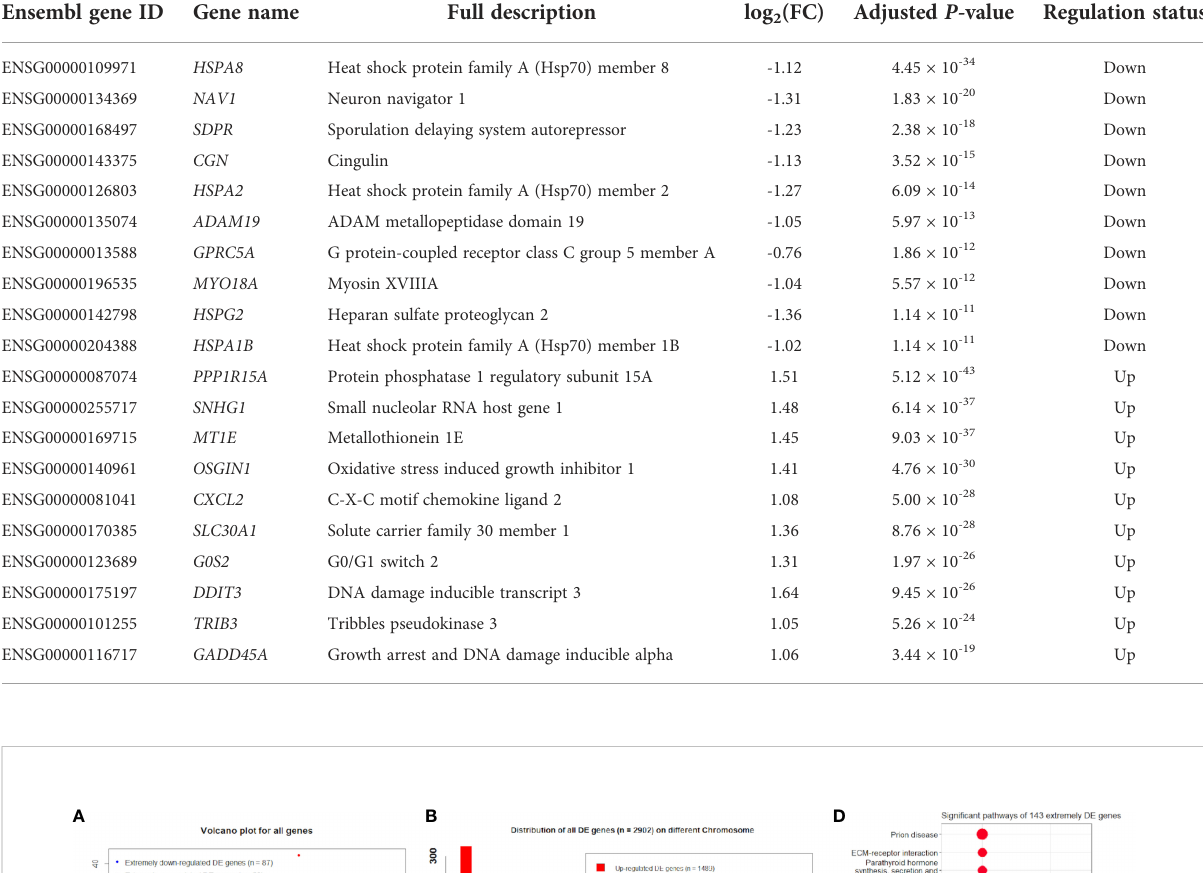
TABLE 2 Top 10 downregulated and upregulated differentially expressed genes.